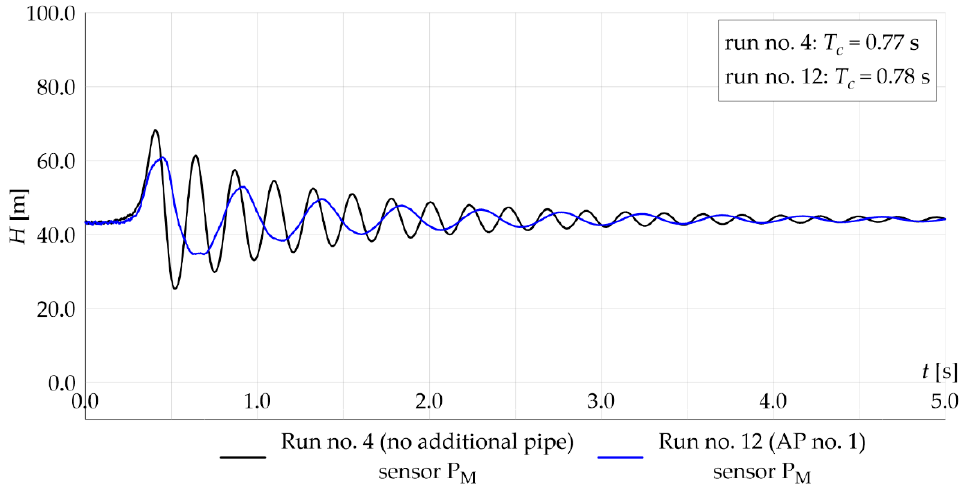
Figure 8. Pressure oscillations recorded during runs no. 4 and no. 12.